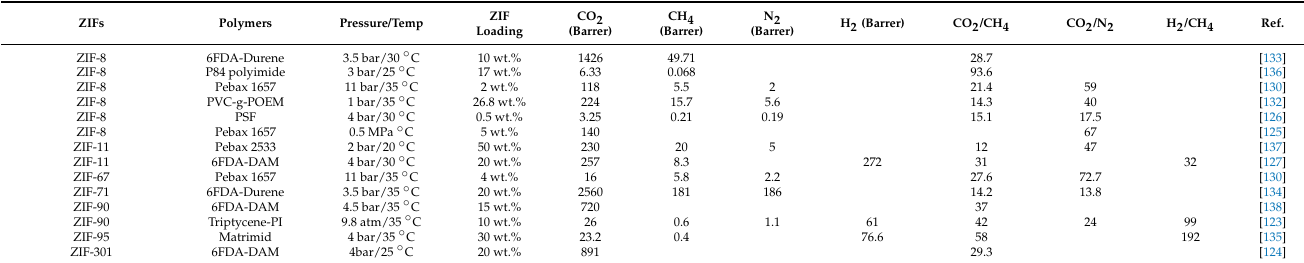
Table 3. Transport properties of unmodified ZIF/polymer mixed matrix membranes.